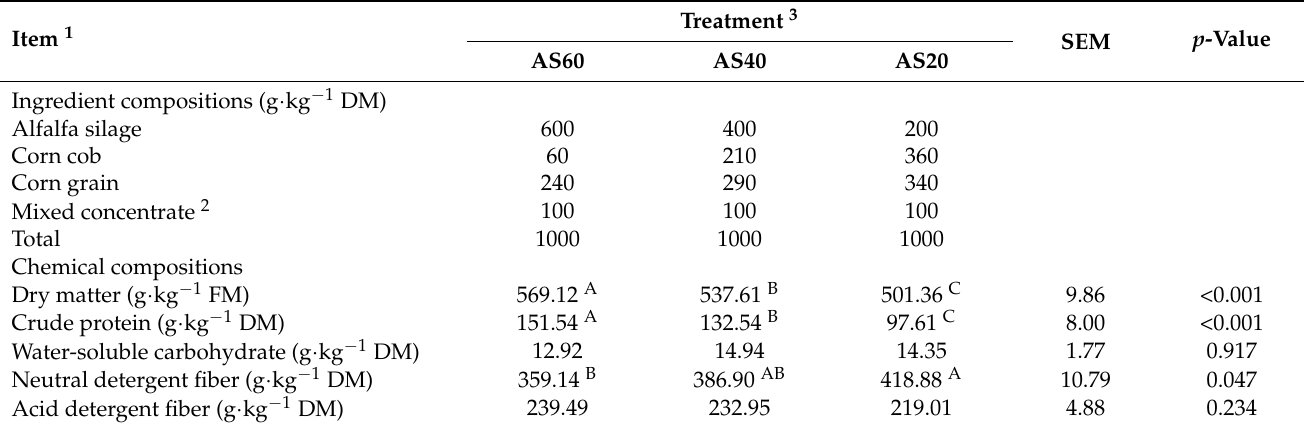
Table 2. Ingredient composition and chemical composition of the total mixed